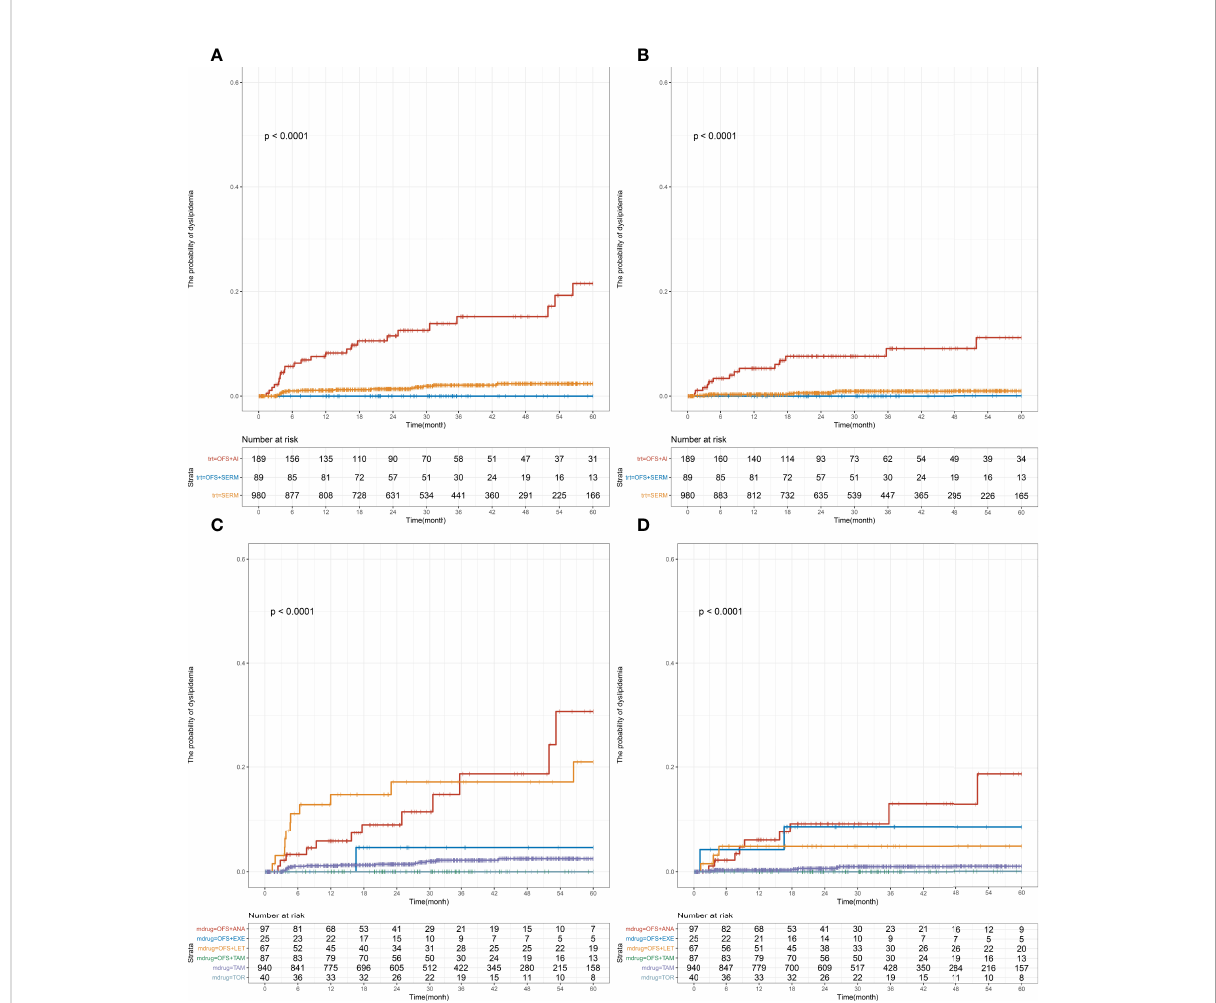
FIGURE 3 Cumulative incidence of abnormal TC and LDL-C levels among early-stage breast cancer premenopausal patients based on the endocrine therapy used. Cumulative curves showing TC (A, C) and LDL-C (B, D) dyslipidemia incidences. p -values were obtained from the log-rank tests for comparisons of abnormal TC and LDL-C incidences between the different endocrine therapy groups. SERM, selective estrogen receptor modulator; TAM, tamoxifen; TOR, toremifene; AI, aromatase inhibitor; ANA, anastrozole; LET, letrozole; EXE, exemestane; OFS, ovarian function suppression; TC, total cholesterol; TG, triglyceride; HDL-C, HDL cholesterol; LDL-C, LDL